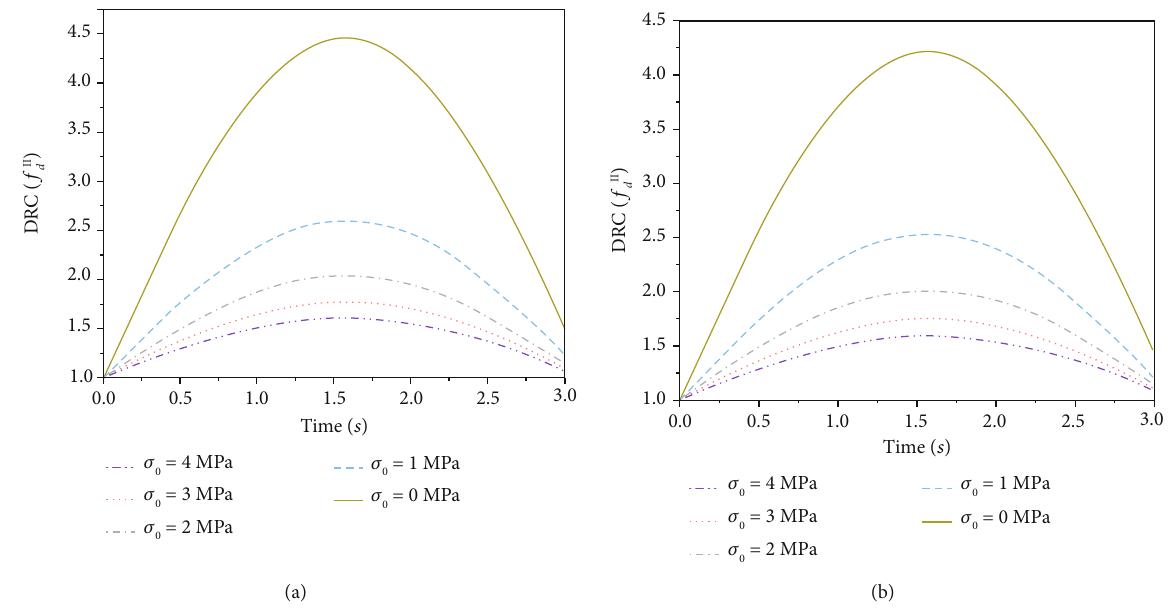
ΙΙ variations with time under di ff erent con fi ning pressure ( σ Figure 9: f d